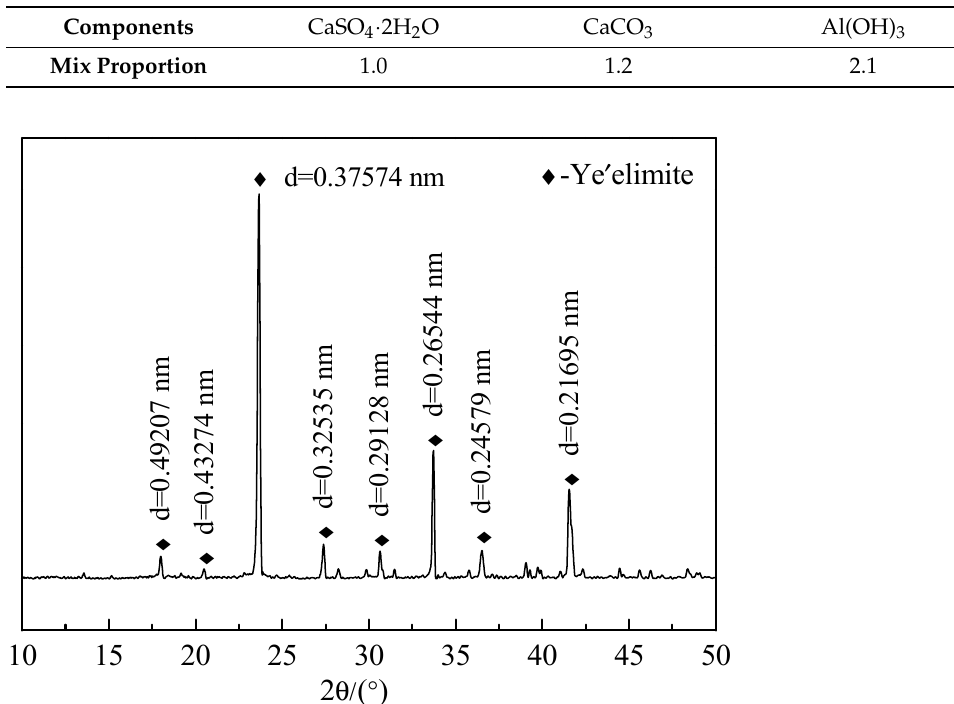
Table 1. Mix proportion of C 4 A 3 S raw material.